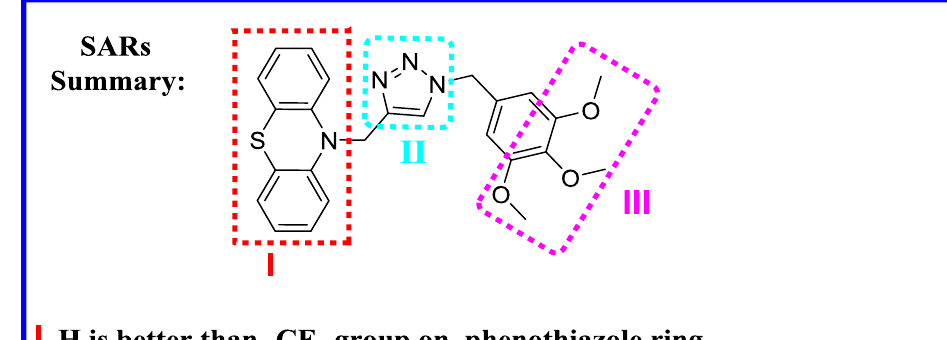
Figure 5. The summary of structure activity relationships.